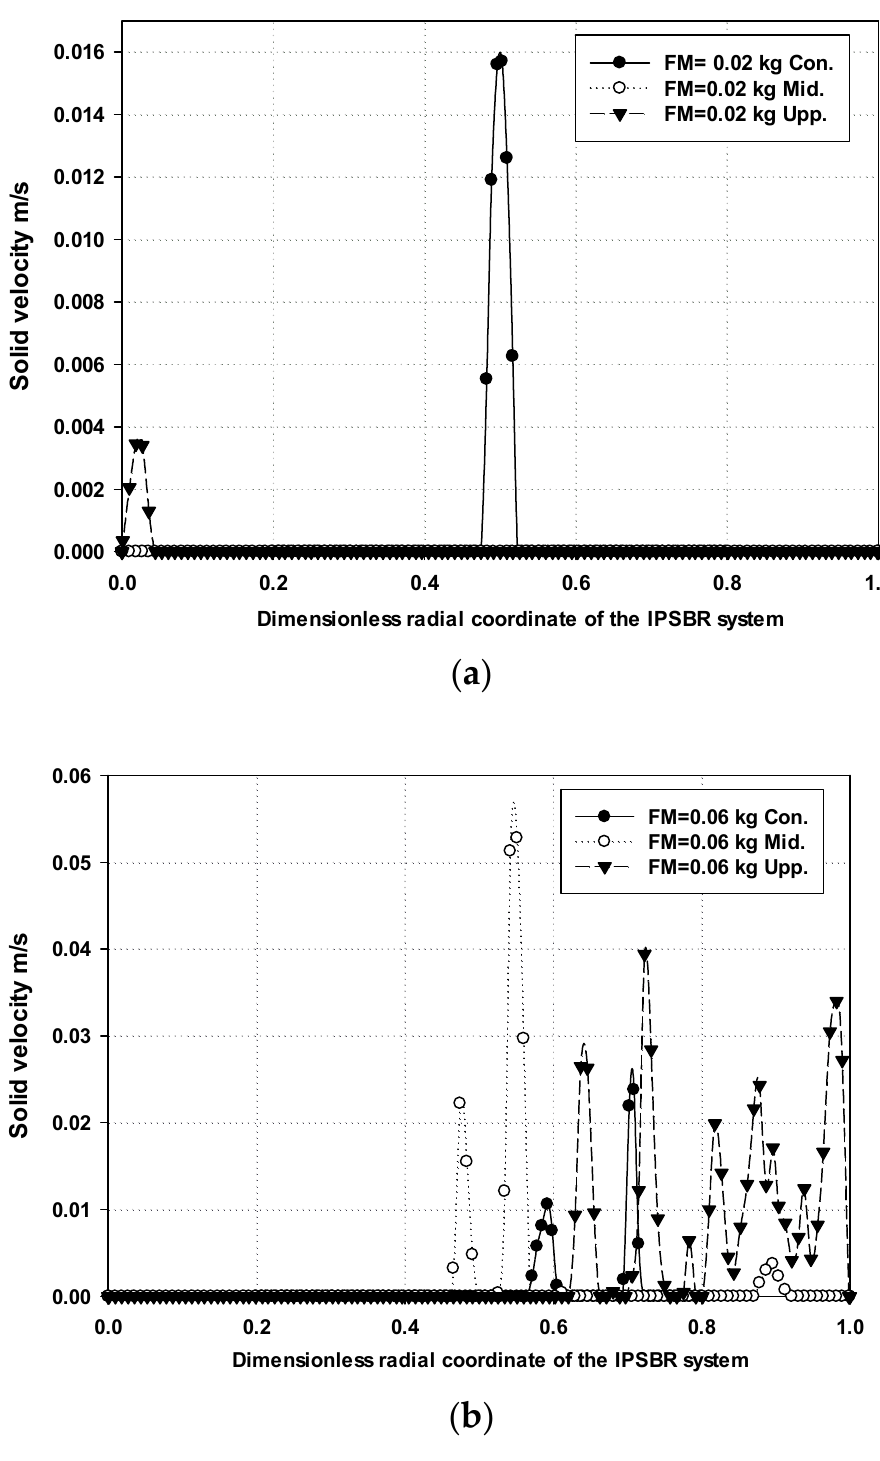
Figure 4. Effect of mixing particle load (( a ) 0.02 kg and ( b ) 0.06 kg) on the average solid velocity at a constant feed gas velocity of 1 m/s, orifice diameter of 0.003 m, gas head of 0.25 m, and mixing particle diameter of 0.0135 m in the conical, middle, and upper